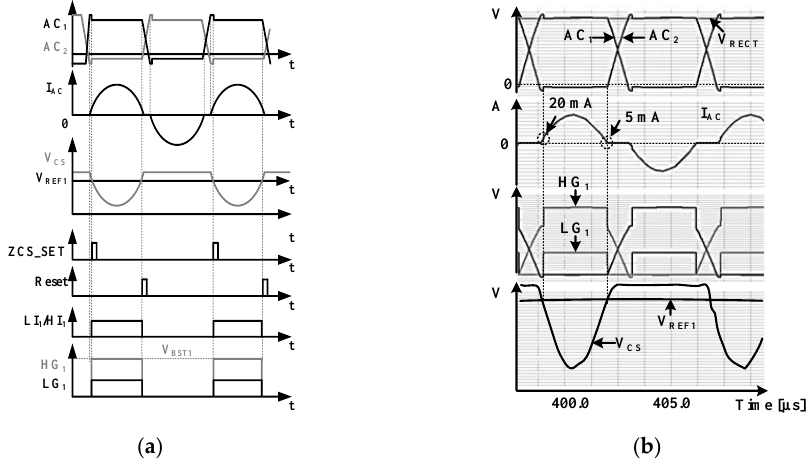
Figure 4. ( a ) Timing diagram of the ZCS circuit. ( b ) Simulation results of the active rectifier.